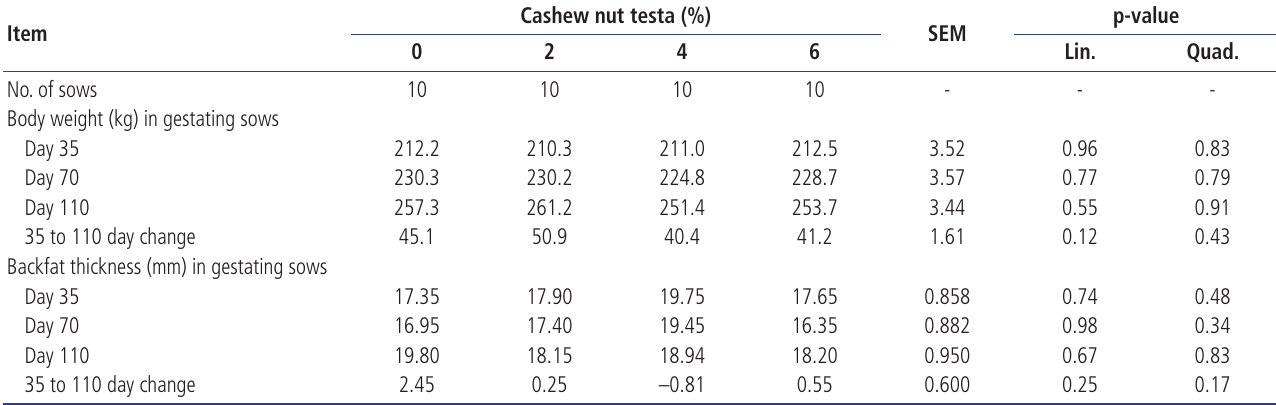
Table 4. Effects of cashew nut testa level on body weight and back-fat thickness in gestating sows